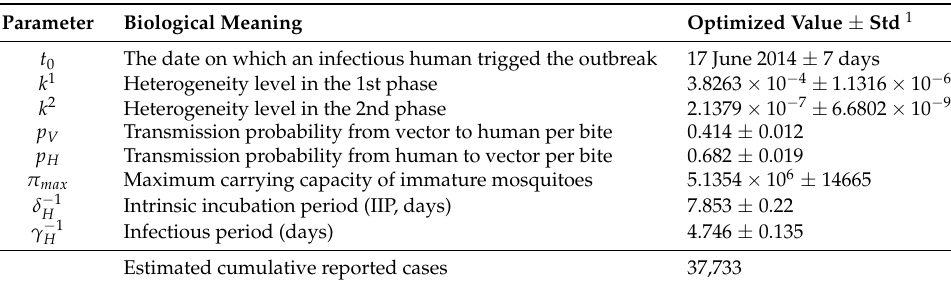
Table 3. Parameter notation, biological meaning, and optimal